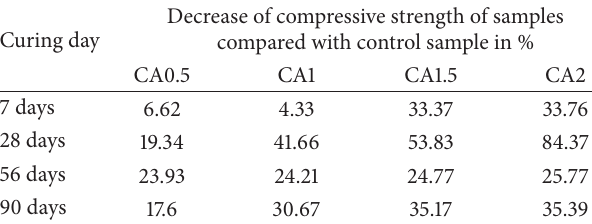
Table 7: Decrease in compressive